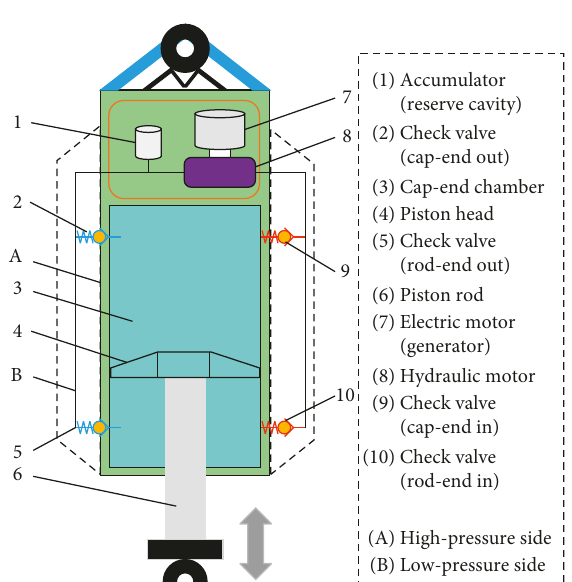
Figure 2: Diagram view of the design concept for